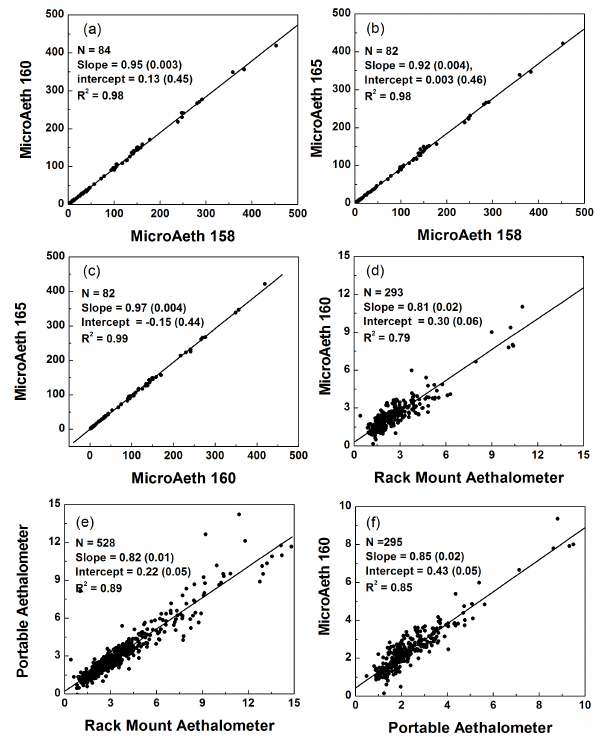
Fig. 3. Inter-comparison of BC measurements between three different models of Aethalometers (microAeth, Rack Mount and Portable) used in our study, standard errors for slope and Y offset at 95% confidence are given in